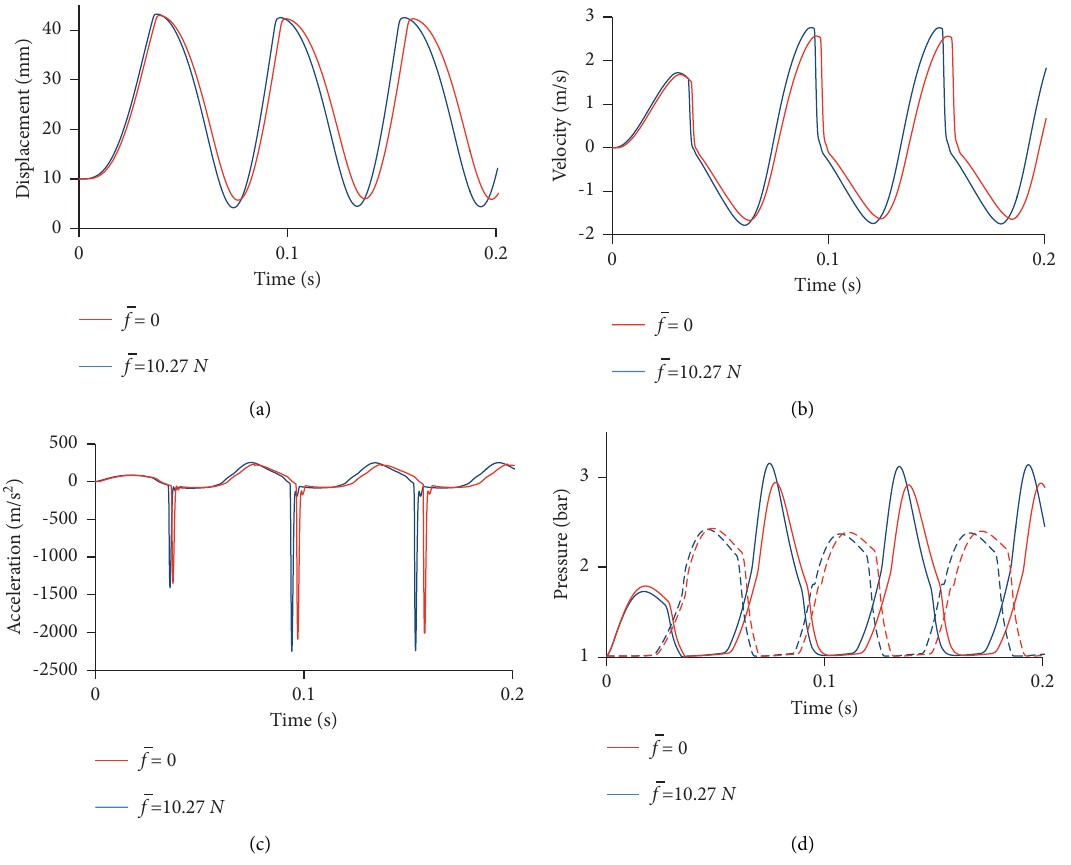
Figure 12: Comparison of simulated results at f � 0 and f � 10 . 27 N. (a) Displacement curves of impact piston; (b) velocity curves of impact piston; (c) impact piston acceleration curves; (d) pressure curves in the front and rear chambers.